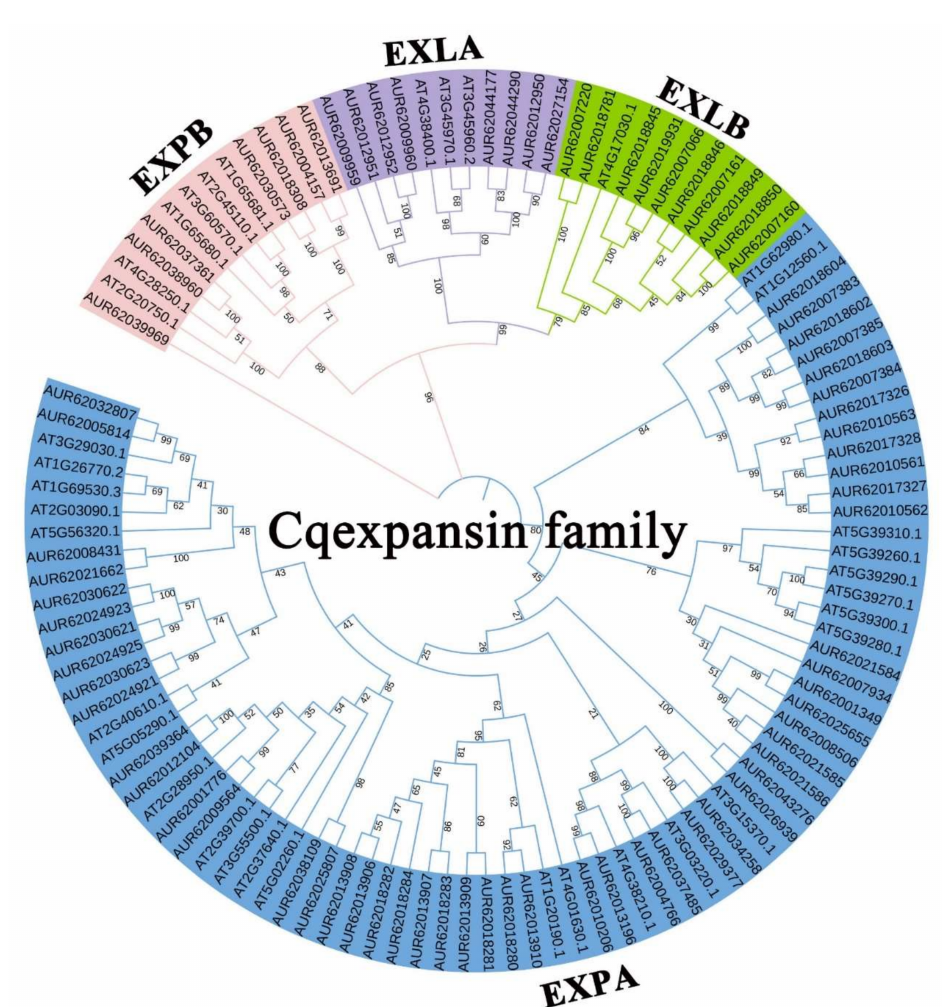
Figure 2. Analysis and identification of Cqexpansin family in